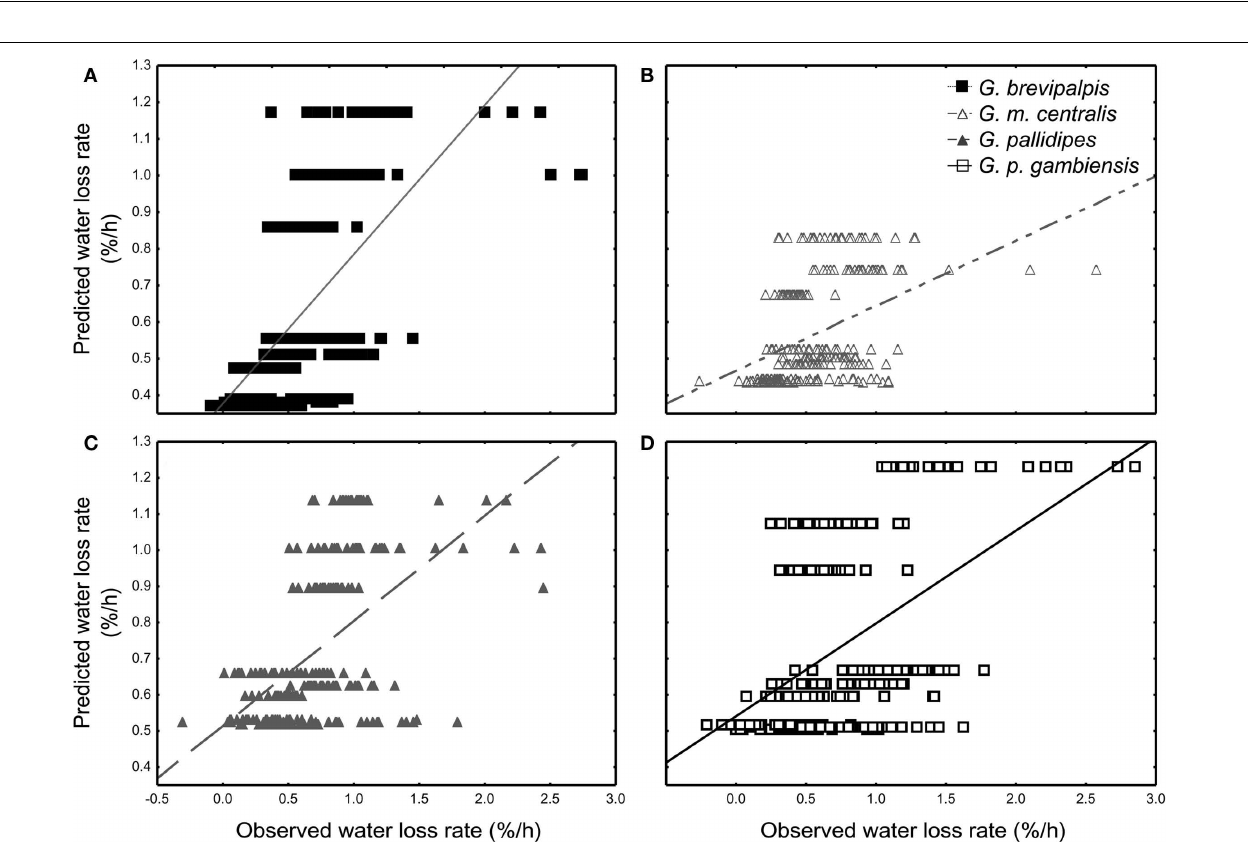
FIGURE 2 | Means ( ± 95% confidence intervals) water loss rates (% of initial body mass lost per hour) across a range of saturation deficits corresponding to the respective temperature and relative humidity treatments for xeric (left) G. pallidipes and G. morsitans centralis and mesic (right) Glossina brevipalpis and